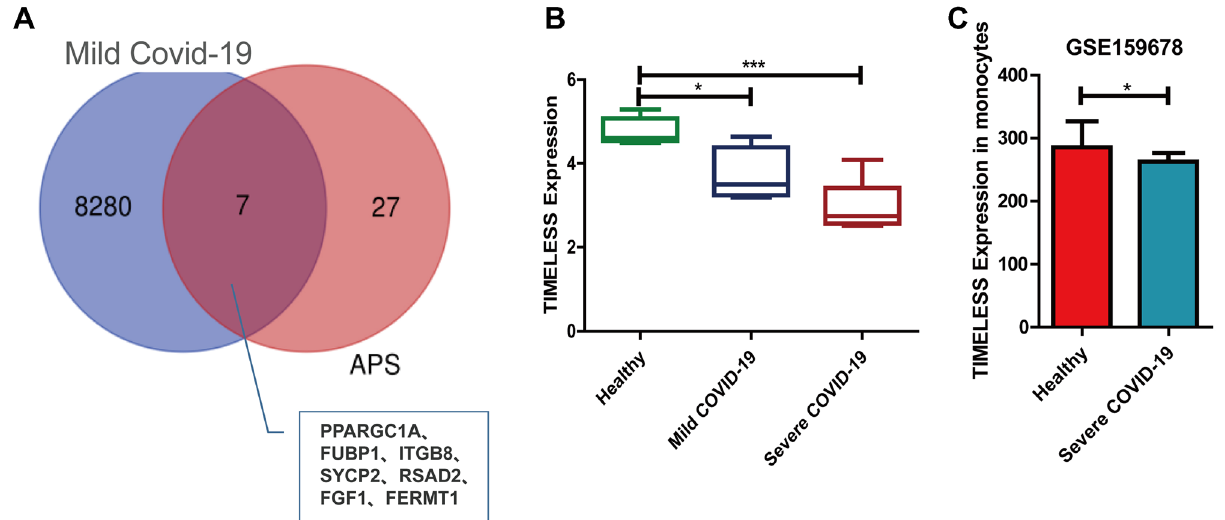
Figure 6. Analysis of TIMELESS gene in mild COVID-19 patients. ( A ) Venn diagram depicting the common DEGs between COVID-19 and APS patients. 8287 genes were included exclusively in the mild COVID-19 group, 33 genes were included exclusively in the APS group and 7 genes were common between the mild COVID-19 and APS groups. Blue circle denotes the number of DEGs in the mild COVID-19 group and pink circle denotes the number of DEGs in the APS group. ( B ) Expression of the TIMELESS gene in healthy, mild and severe COVID-19 patients. * P < 0.01, *** P < 0.001. ( C ) Validation of the expression of TIMELESS in monocytes from severe COVID-19 patients from the GSE159678 dataset. * P < 0.05.